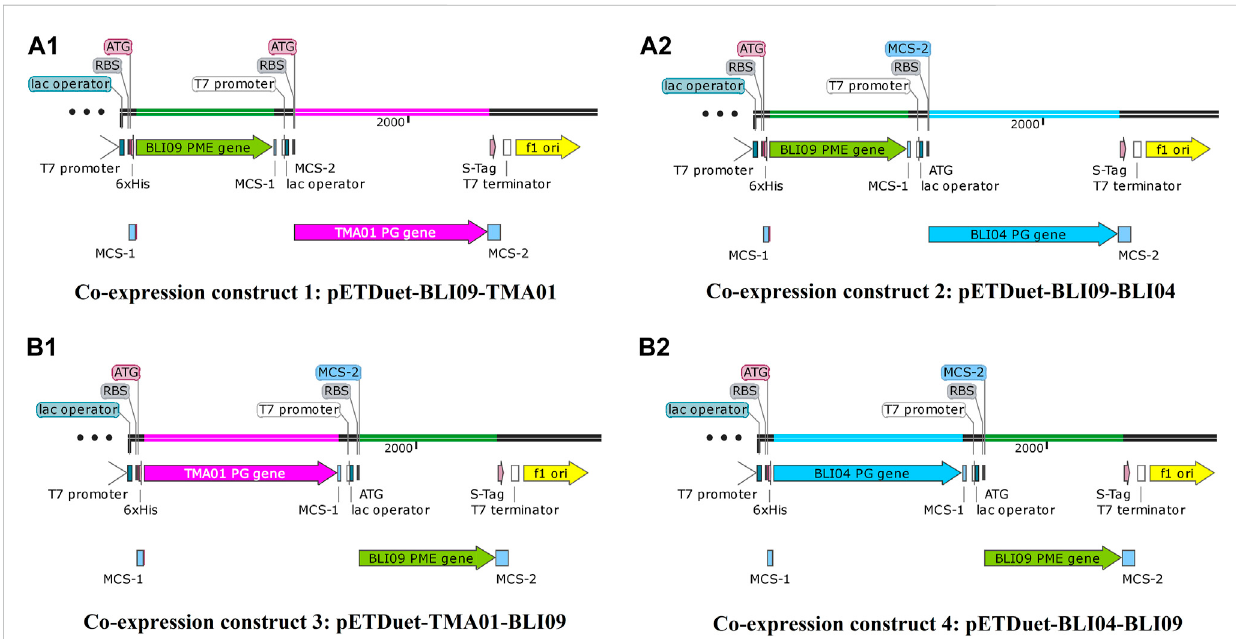
FIGURE 1 Co-expression constructs containing BLI09 PME with either TMA01 or BLI04 exo-PGs in pETDuet-1. (A1) Co-expression construct 1: pETDuet- BLI09-TMA01, where BLI09 is in MCS1 (green) and TMA01 in MCS2 (pink); and (A2) co-expression construct 2: pETDuet-BLI09-BLI04, where BLI09 is in MCS1 (green)and BLI04 inMCS2 (light blue). (B1) Co-expressionconstruct 3:pETDuet-TMA01-BLI09, where TMA01 isinMCS1 (pink) and BLI09 inMCS2 (green); and (B2) co-expression construct 4: pETDuet-BLI04-BLI09, where BLI04 is in MCS1 (light blue) and BLI09 in MCS2 (green). Co-expression constructs were plotted using SnapGene 4.2.11 software. PME: pectin methylesterase, exo-PG: exo-polygalacturonase, MCS: multiple cloning